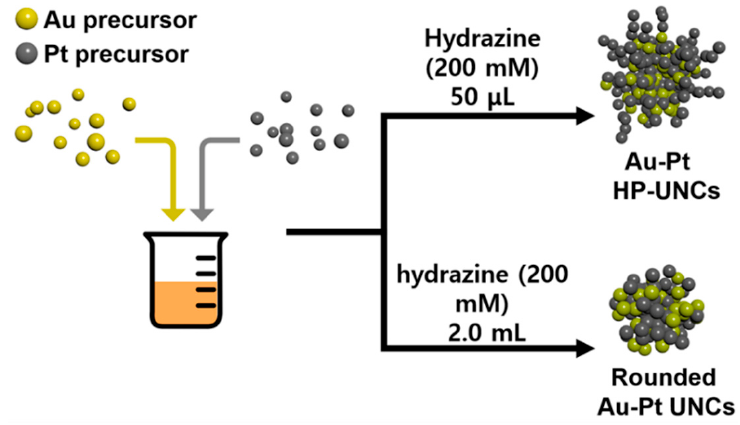
Figure 1. Schematic illustration for Au–Pt HP-UNCs and rounded Au–Pt UNCs. Typically, a HAuCl 4 /K 2 PtCl 4 mixture in a molar ratio of 1:1, CTAC, and hydrazine were added into deionized water, and the reaction mixture was heated at 100 °C for 1 h. Figure 2a,b display typical scanning electron microscopy (SEM), and transmission electron microscopy (TEM) images of the products, respectively, in which highly porous UNCs with average branch thickness of 6.2 ± 0.9 nm and average diameter size of 37.4 ± 5.5 nm can be observed as major products. Figure 3a,b show the high porosity of the UNCs from con- siderably porous dendritic branches and the fast Fourier transform (FFT) pattern obtained from a square region of a highly porous UNC reveals that the synthesized nanostructures are highly crystalline (Figure 3c). In addition, a d-spacing of 2.32 Å is observed between adjacent lattice fringes, which corresponds to the (111) planes of face centered cubic (fcc) Au–Pt (Figure 3d) [25] and demonstrates the Au–Pt bimetallic nature of the HP-UNCs. Noticeably, the high-resolution TEM (HRTEM) image displayed in Figure 3d shows many low-coordinated surface atoms at the branches of the Au–Pt HP-UNCs, which can serve as highly efficient active sites for electrochemical fuel oxidation reaction [26].